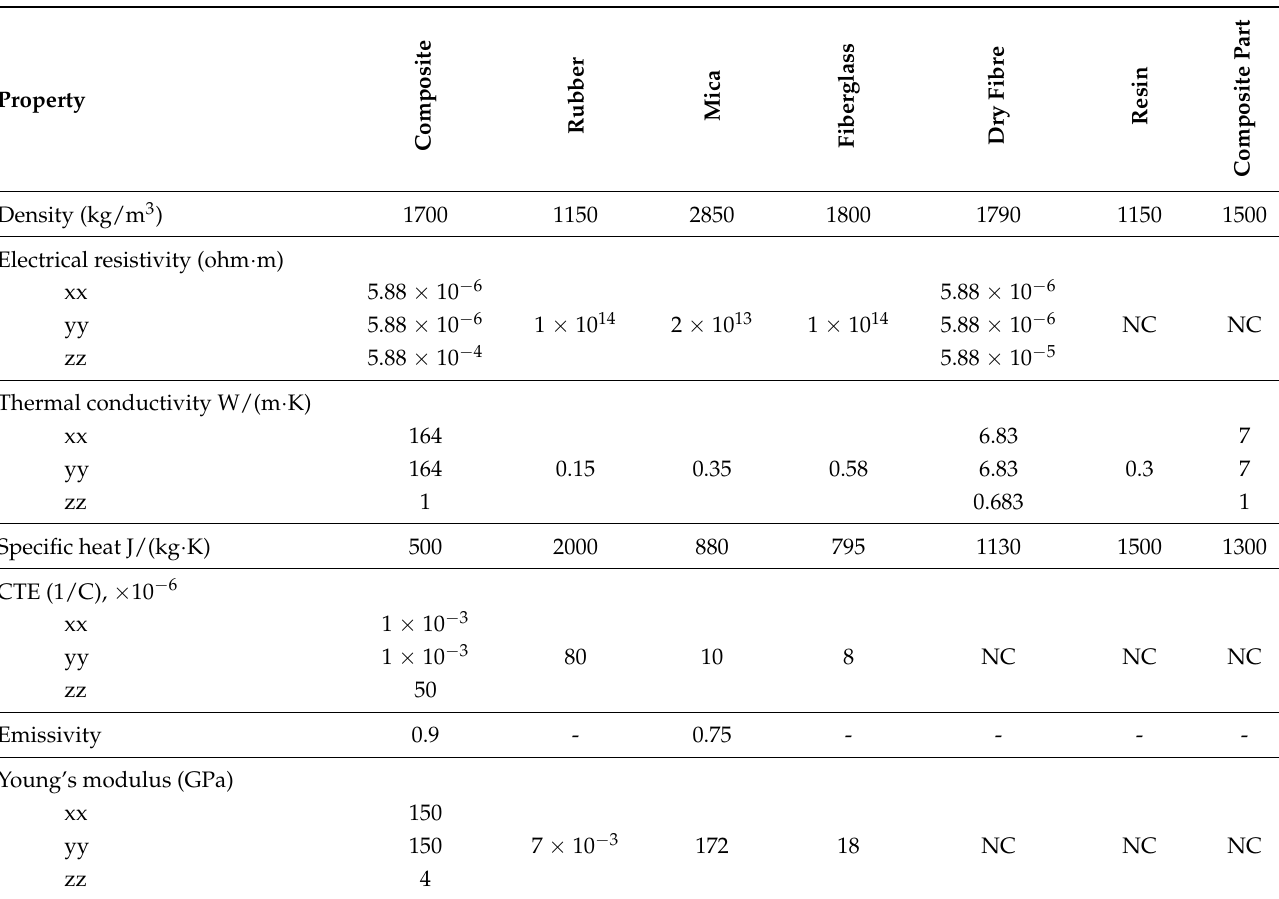
Table 1. Material Table 1. Material properties.